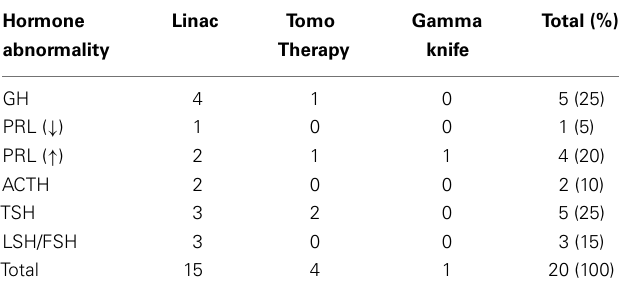
Table 3 | Specific endocrine deficits by treatment